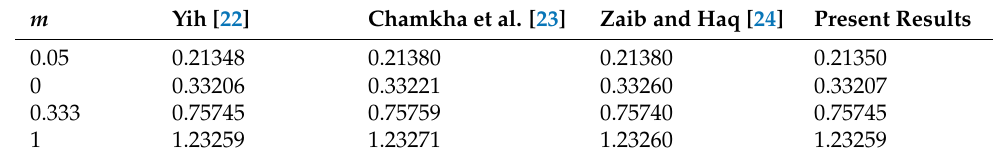
Table 2. Comparison of skin friction with available data for several values of m when other parameters are